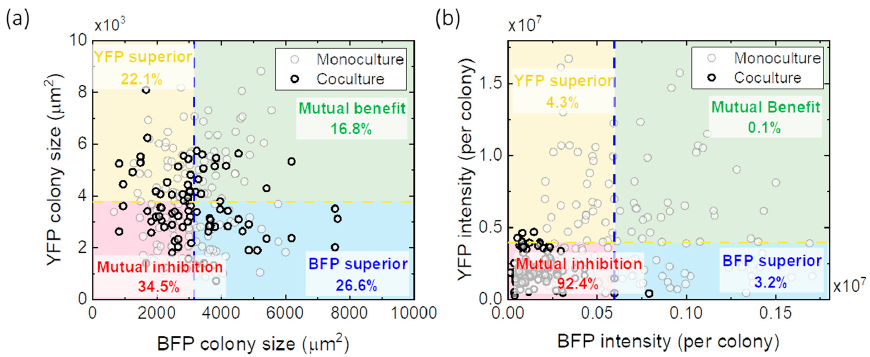
Figure 5. Distribution of interactions between two strains of E. coli during co-culture in gel beads based on ( a ) colony size and ( b ) fluorescence intensity. The blue and yellow dashed lines indicate the median value of monoculture results. Grey dots present random pairs of monoculture colonies, and red dots show random pairs of co-culture colonies. The numbers on the figures are the average values of results from 1000 generated random data sets with a standard error < 2.58%.